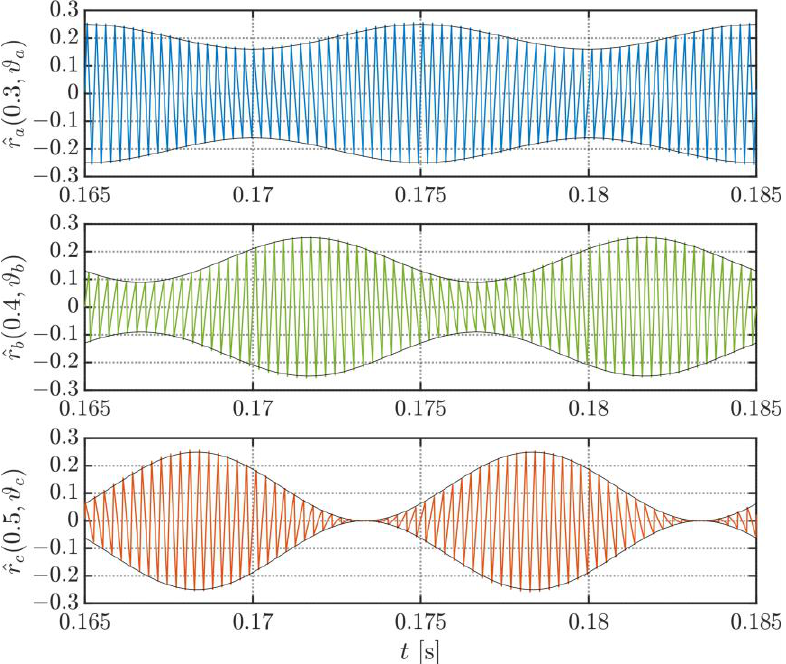
Figure 5. Normalized current ripples (fundamental current removed) of the three phases in case of magnitude unbalance ( m a = 0.3, m b = 0.4, and m c = 0.5) with calculated envelopes (black lines) at a switching frequency of 3.6 kHz.